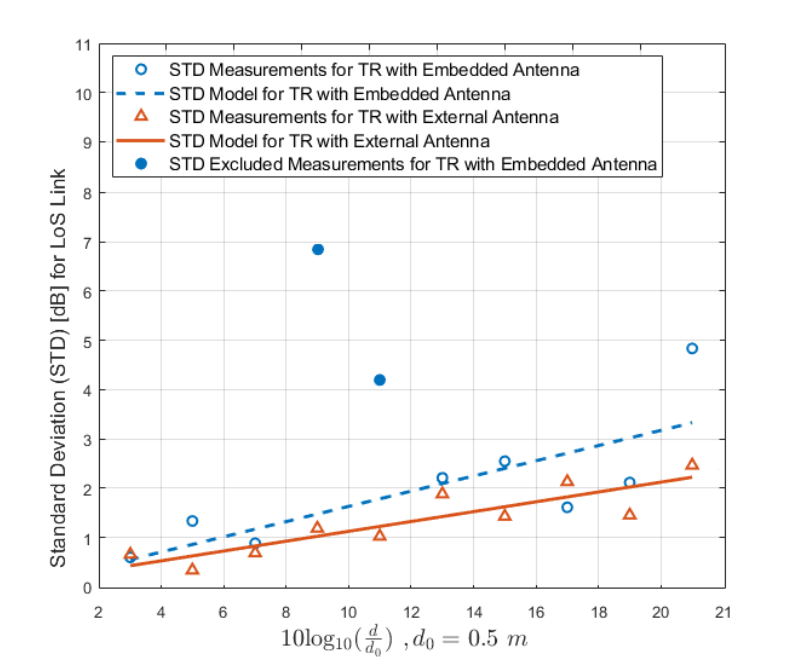
Figure 6. Standard deviation at each location for the Line-of-Sight links using both types of IQRF transceivers.